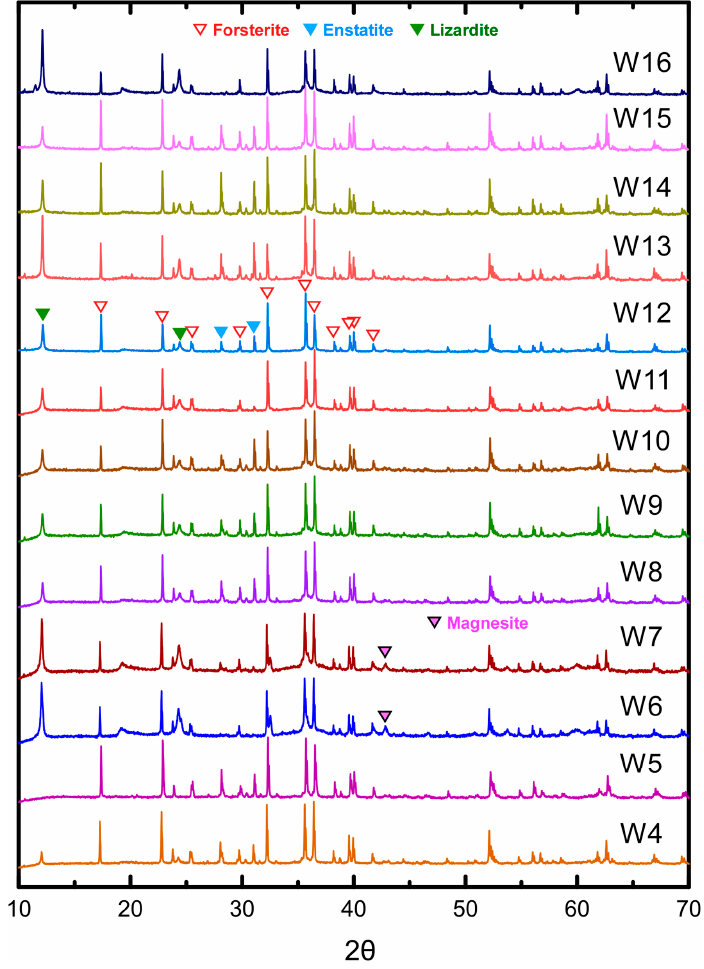
Figure 3. XRPD patterns of peridotite samples.